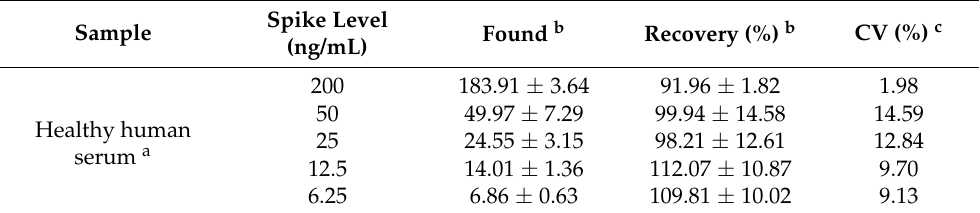
Table 2. Recovery analysis of BNP in healthy human serum sample by the proposed multifunctional immunocolorimetric sensing system. Spike Level Sample Found b Recovery (%) b CV (%) c (ng/mL)